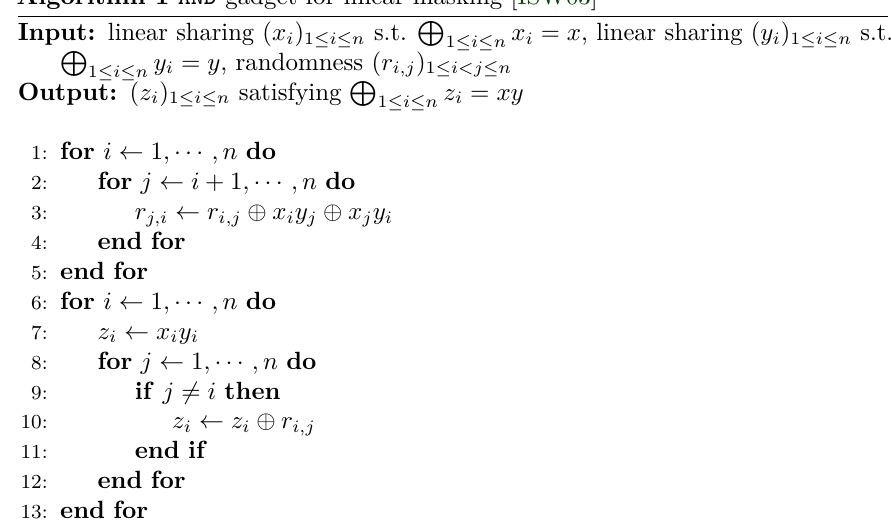
Algorithm 1 AND gadget for linear masking